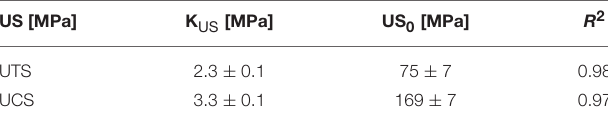
TABLE 4 | Coefficients for relation of ultimate strengths to hardness including standard